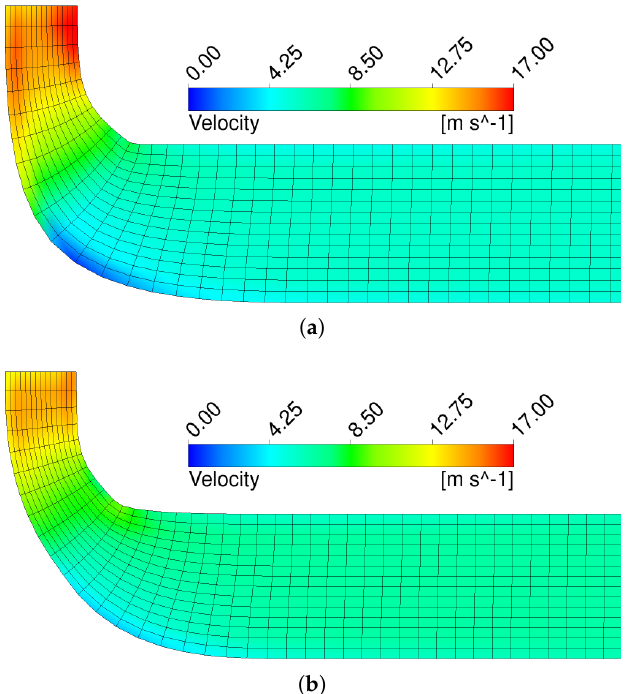
Figure 19. Velocity field in the meridional channel for the baseline ( a ) and the optimized ( b )